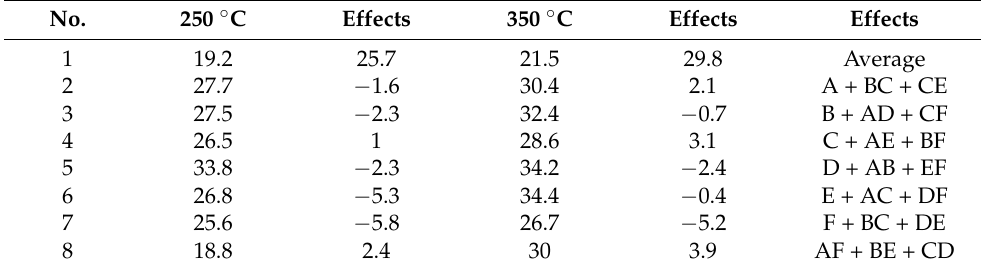
Table 12. Average values and standardised effects with respect to zone III. Values in mg.